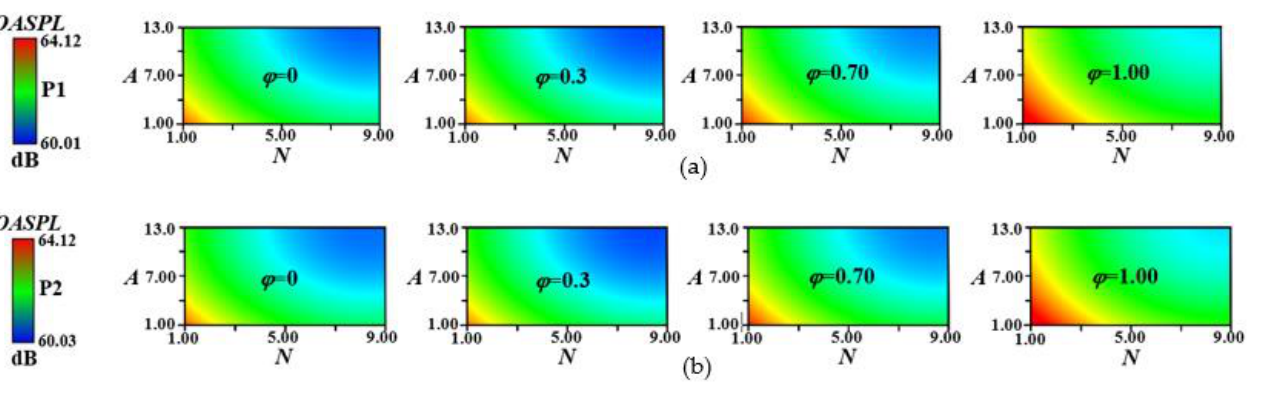
Figure 10. Response surface contours. ( a ) P1; ( b )